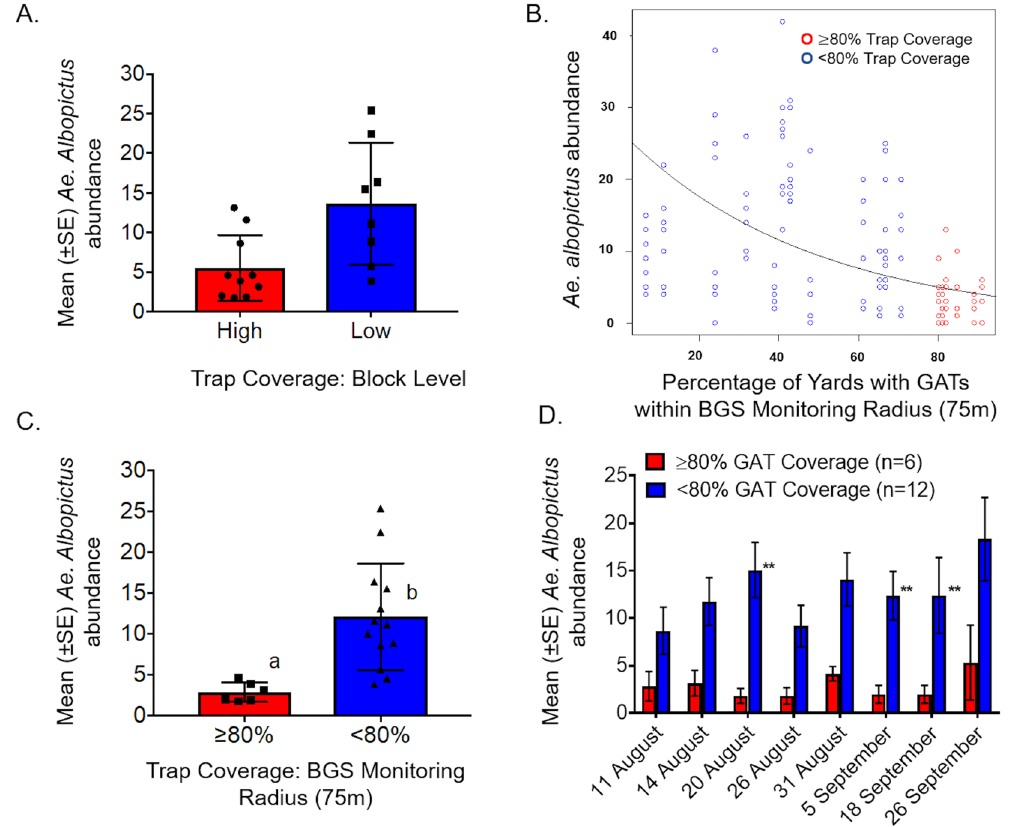
Figure 2. ( A ) Mean ( ± SE) female Ae. albopictus abundance at the block level (high > 50% trap coverage; low < 50% trap coverage) determined by the number of yards per block with GATs. ( B ) Negative binomial regression of the relationship between trap density and female Ae. albopictus abundance. ( C ) Mean ( ± SE) female Ae. albopictus abundance by high ( ≥ 80%) and low ( < 80%) trap coverage (percent of yards with traps) within a 75 m surveillance radius from BGS monitoring sites. ( D ) Mean ( ± SE) female Ae. albopictus abundance during each collection point in high ( ≥ 80%) and low ( < 80%) coverage monitoring sites. Different letters or presence of ** indicate statistical significance between observations ( P <